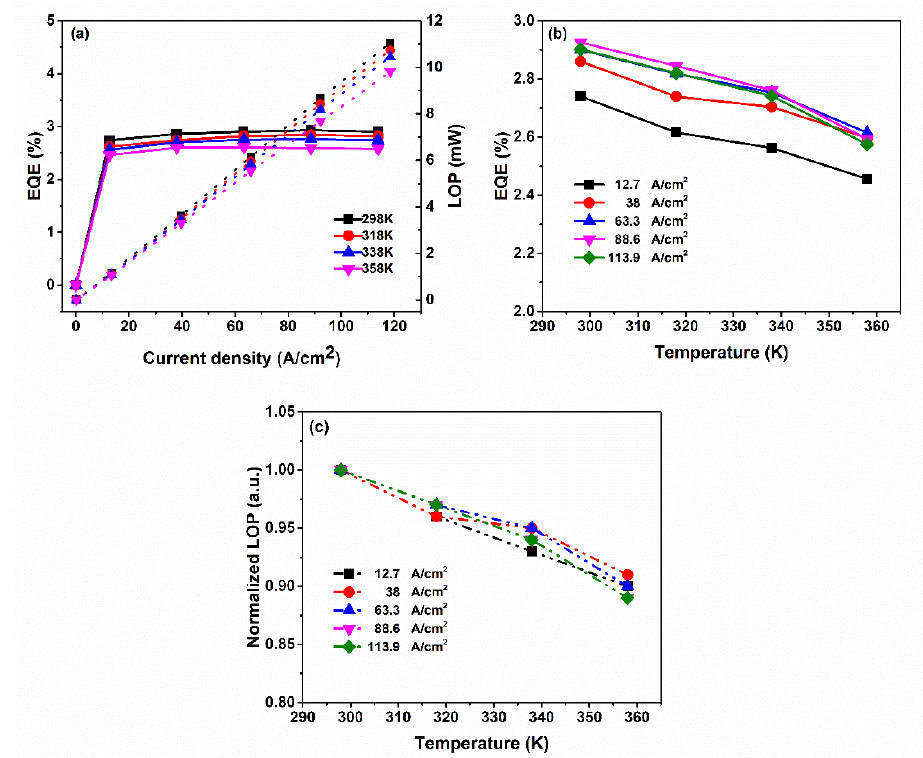
Figure 2. ( a ) EQEs (solid lines) and LOPs (dotted lines) of the 293 nm AlGaN-based UVB-LED plotted with respect to the forward current and measured at four different temperatures. ( b ) T-droop plotted with respect to temperature and measured at various forward currents. ( c ) Normalized LOPs plotted with respect to temperature and measured at various forward currents.